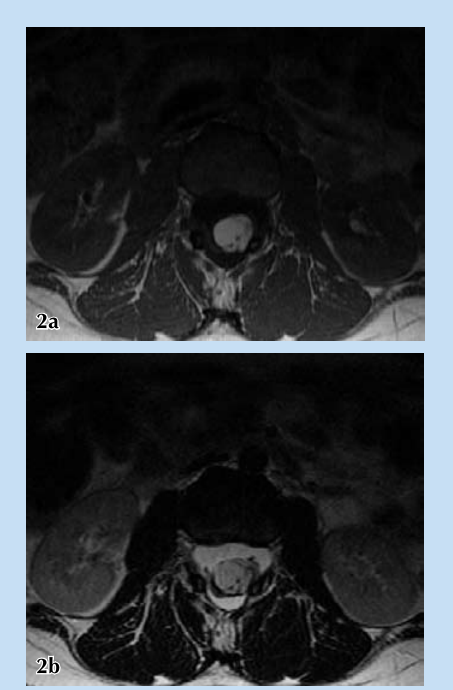
Fig. 2. Unenhanced axial MRI images with T1-weighted (Fig. 2a) and T2-weighted (Fig. 2b) sequences.